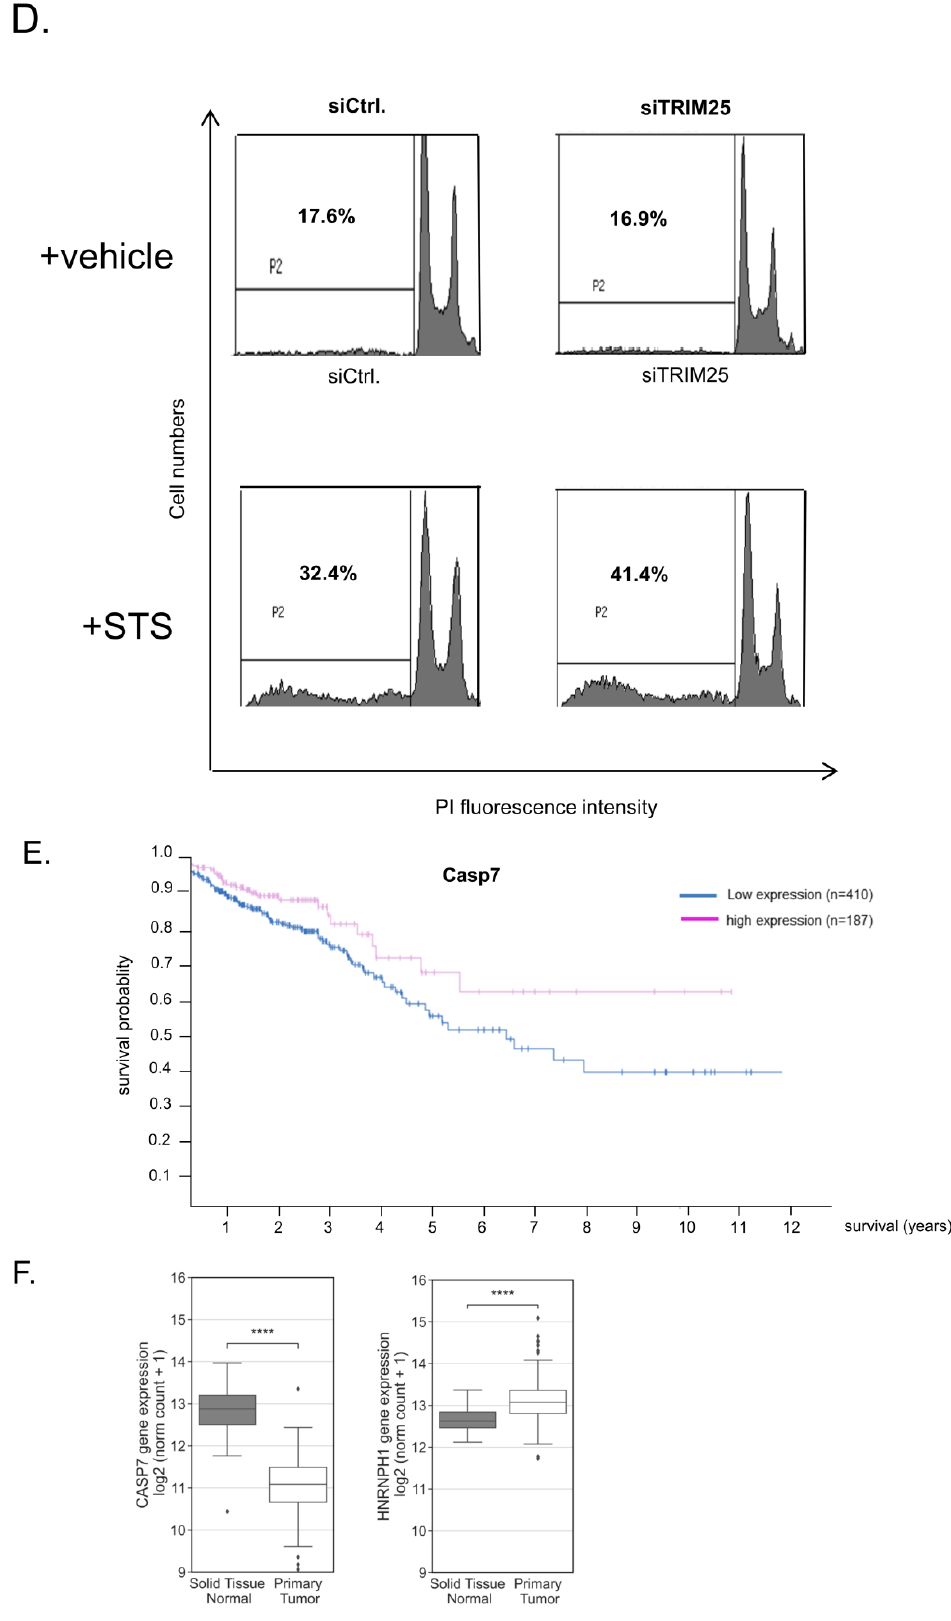
Figure 6. ( A – D ) Functional consequences of caspase-7 for apoptotic cell death. ( A ) RKO cells were either transfected with the indicated amounts of cDNA coding for human caspase-7 (pcDNA3-Casp7-Flag) or, alternatively, with the same amount of empty vector (pcDNA3-Flag). Forty-eight hours after transfection, PARP-1 cleavage and the levels of the indicated precursor caspases were monitored by Western blot analysis, and β -actin was used as a loading control. Levels of pro- caspase-7 are additionally shown at a higher exposure (h. exp.), * p ≤ 0.05 . ( B ) Accordingly, cells were transfected with increasing amounts of pcDNA3-Casp7 (grey bar) or with the same amount of empty vector (black bar), as indicated for 48 h before being subjected to flow cytometric analysis for determination of sub-G1 accumulation (P2) by propidium iodide (PI) staining. ( C ) Values represent means ± SD (n = 3). ** p ≤ 0.01 from transf ections with 0.5 µg pcDNA3-Casp7-Flag (+ pcDNA-Casp7) vs. empty vector (+ empty) transfectants set as one-fold. ( D ) Silencing of TRIM25 increases stauro- sporine (STS)-induced accumulation of colon carcinoma cells in sub-G1 phase. RKO cells were trans- fected with control siRNA duplexes (siCtrl.) or with siRNA duplexes of TRIM25 (siTRIM25) for 48 h before being treated for 6 h with 250 nM of STS (+STS) or with vehicle (+vehicle). Sub-G1 arrest was analyzed by flow cytometry after PI staining. Values represent means % of sub-G1 accumula- tion ± SD (n = 3) siTRIM25 vs. siCtrl. ( E , F ) Impaired expression of casaspe-7 in CRC patients corre- lates with reduced survival. Kaplan – Meier overall survival curves of human CRC patients with low (blue lines, n = 410) vs. high (red lines, n = 187) caspase-7 based on data from the Human Protein Atlas [40]. ( F ) Comparison of expression levels of caspase-7 and hnRNPH1 in colorectal cancer tis- sues (n = 288) compared with solid normal colon tissues (n = 48), analyzed with the UCSC Xena browser (htpps://xena.ucsc.edu); accessed on 22 december 2022) [41] and based on TCGA data. Non- parametric Mann – Whitney U test was used to confirm statistical significance. **** p ≤ 0.00 01. 3.9. Reduced caspase-7 Expression in Primary Colonic Tumor Samples Correlates with Poor Survival To finally evaluate whether the observed downregulation of caspase-7 in human CRC cells could be pathologically relevant for human colon carcinoma, we employed in silico analysis by using two different online tools. First, Kaplan – Meier curves obtained from the Human Protein Atlas database [40] from 597 patients clearly indicated that CRC